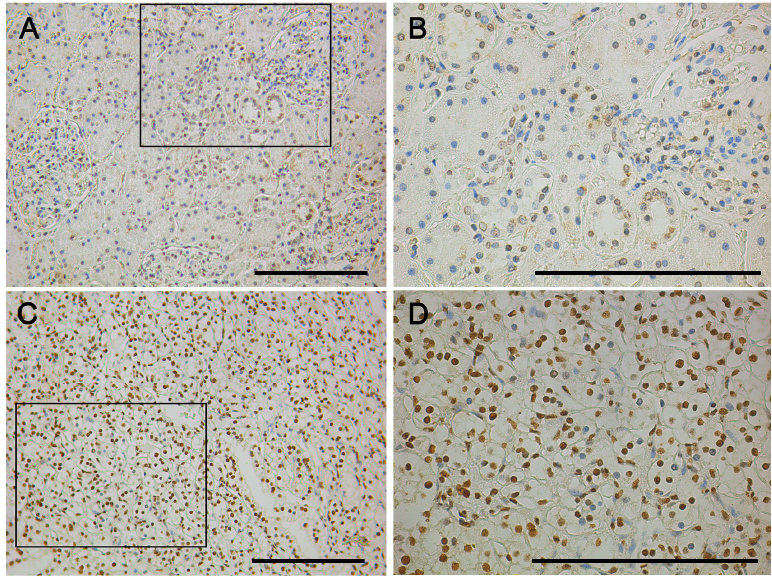
Figure 2. IHC of EN2 expression in CCRCC using MAB2600. ( A and B ) kidney normal tissue, boxed areas in the 200× graphs are shown in the corresponding 400× graphs; ( C and D ) kidney tumor tissue, boxed areas in the 200× graphs are shown in the corresponding 400× graphs. Insert bar = 100 μ